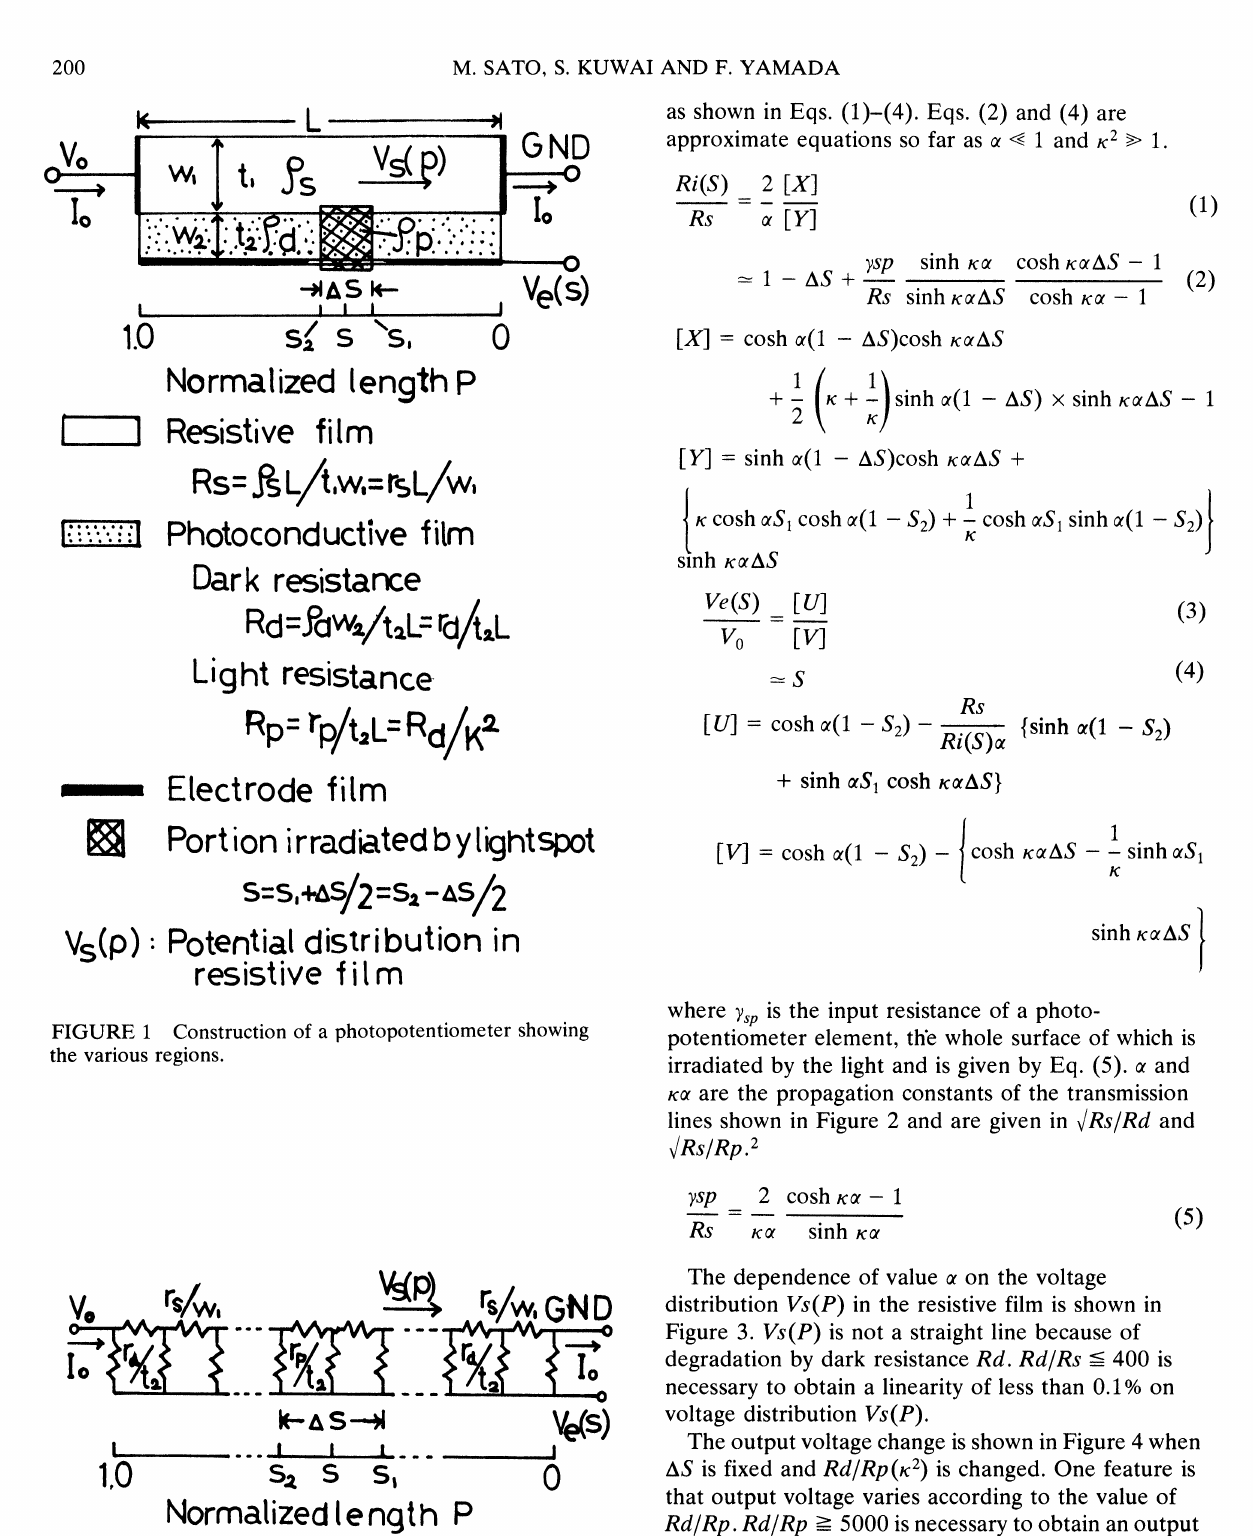
FIGURE 2 Equivalent circuit of a photopotentiometer.